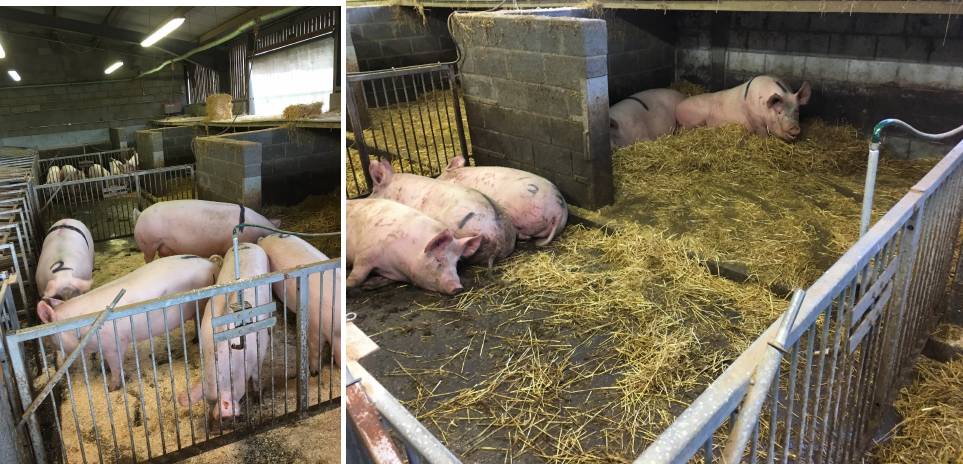
Figure 2. Mix procedure. Older sows are mixed with younger sows (left-hand image) in order to establish social defeat (right-hand image) and a “stressed”